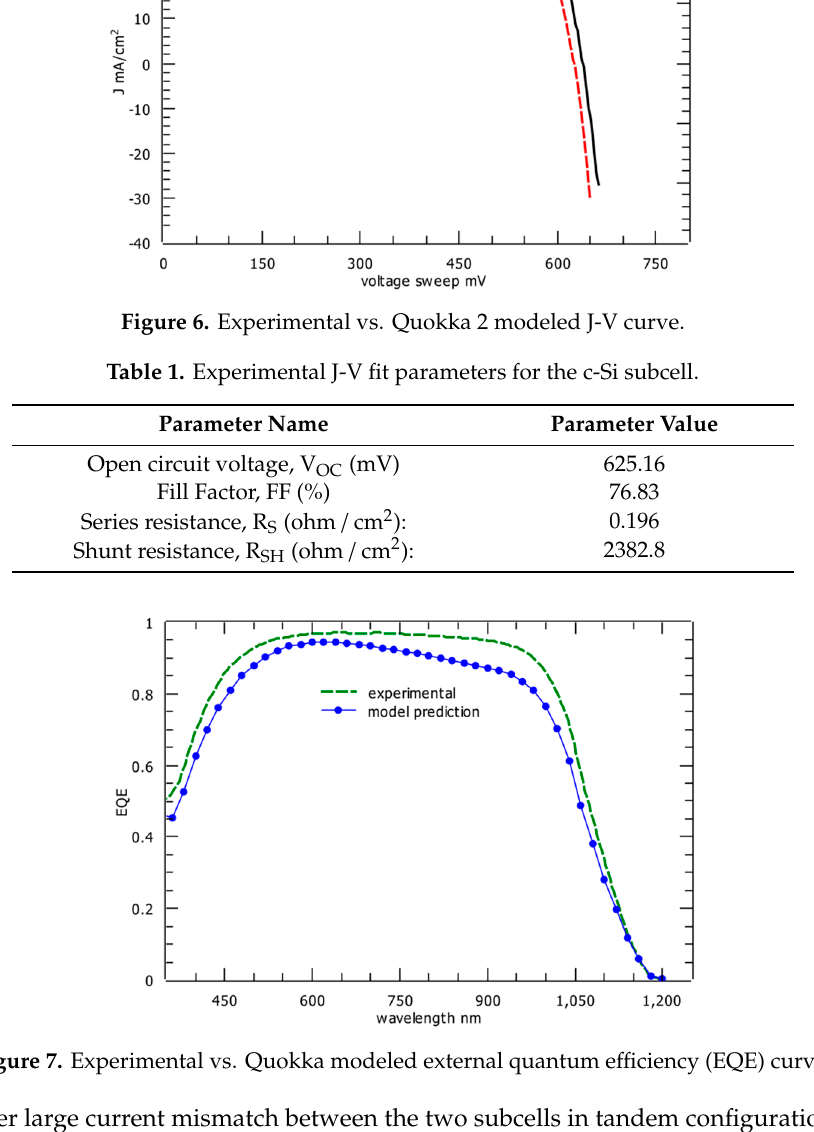
Figure 7. Experimental vs. Quokka modeled external quantum efficiency (EQE) curve.